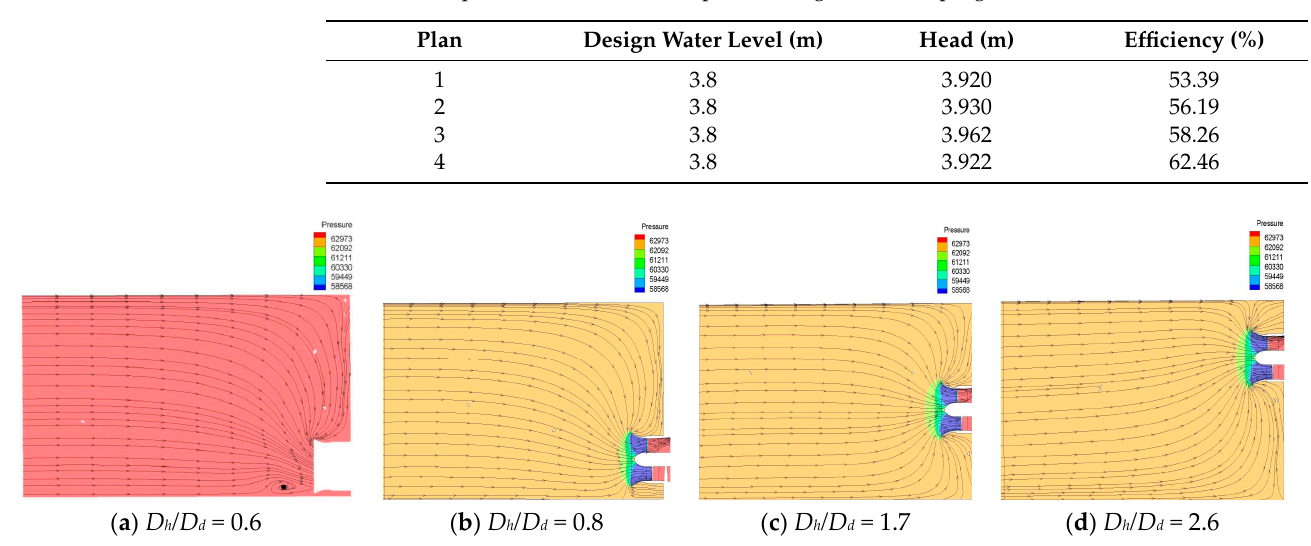
Table 3. CFD performance of each suspended height research program.